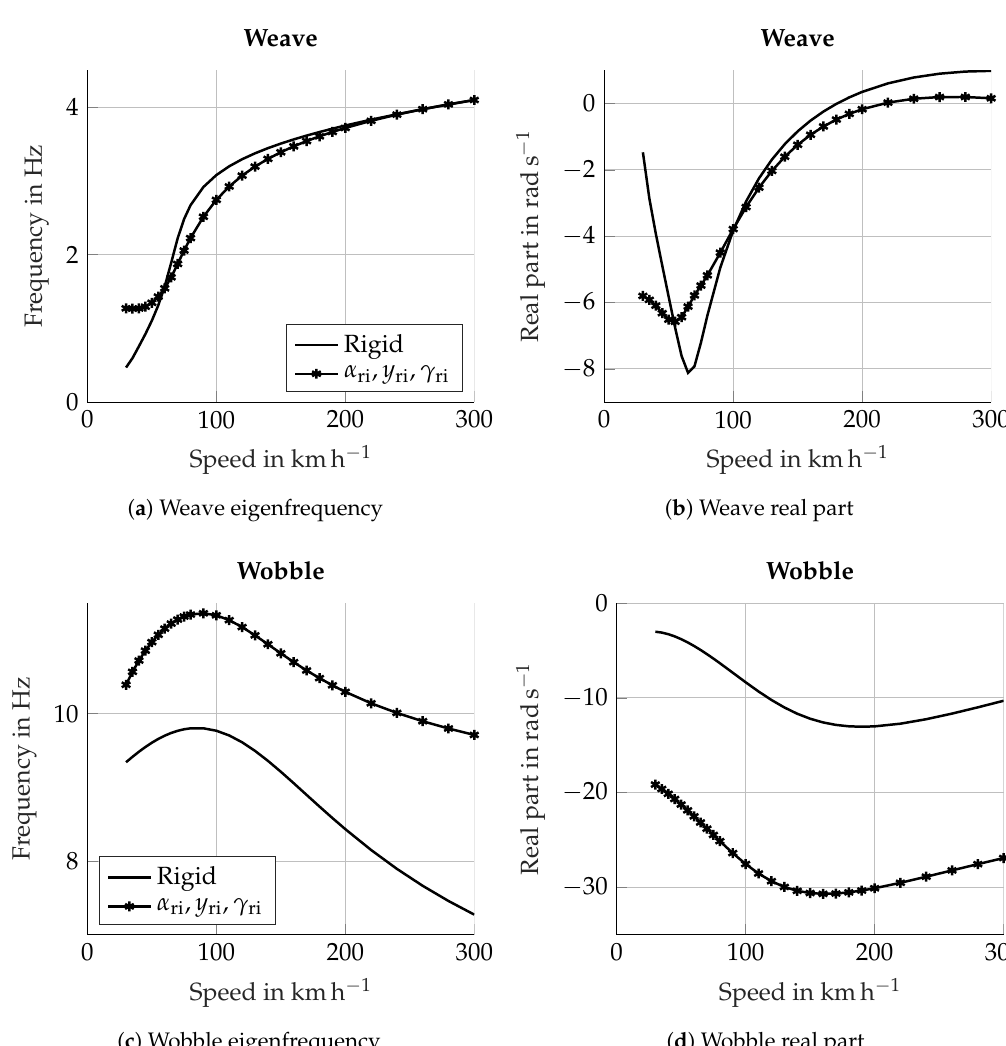
Figure 16. Effect of the whole rider model (3-DoF) on the weave and wobble